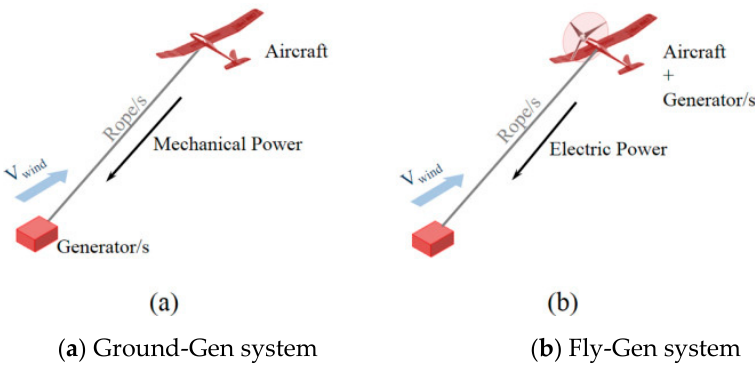
Figure 1. Examples of airborne wind energy systems (AWES) [12].